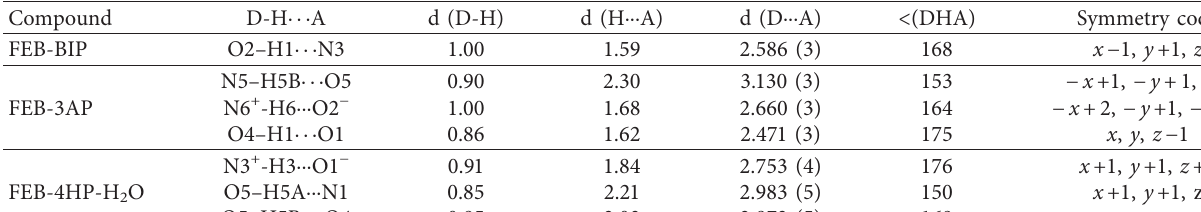
Table 2: Hydrogen bond parameters of FEB cocrystal and